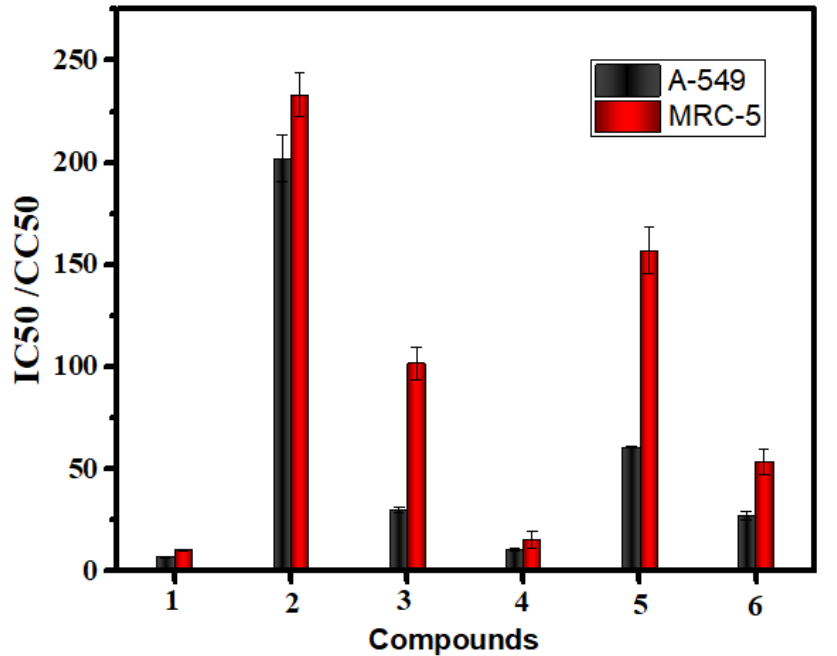
Figure 9. The comparison of anticancer activity for complexes ( 2 – 6 ) with standard drug cisplatin against ( 1 ) against selected human cell lines.